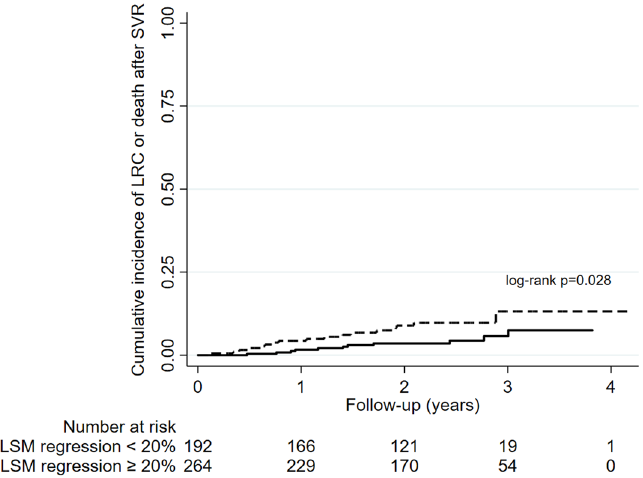
Figure 3. Cumulative incidence of liver related complications or death according to regression of liver stiffness measurement (LSM) after sustained virological response (SVR) [all log-rank tests].